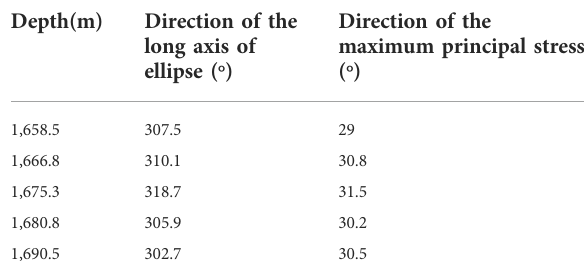
TABLE 2 Direction of the long axis of ellipse and maximum principal